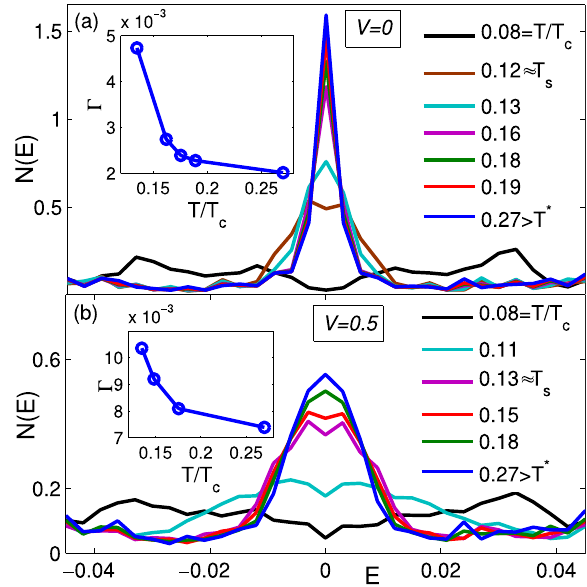
Fig. 6 Low-energy density of states. Spatially averaged density of states N ( E ) within GIMT at different temperatures for clean ( a ) and disordered samples ( b ). N ( E ) is extracted with a constant broadening parameter, which excludes the temperature broadening caused by the Fermi – Dirac distribution. A clear zero-bias peak is seen for T > T s , with insets showing its full width at half maximum, FWHM. The increase of FWHM with decreasing temperature shows that the zero- bias peak is broadened beyond the Fermi – Dirac distribution effects, i.e. a temperature-independent effect. For T < T s , N ( E ) develops a full gap (small remnant N ( E ) inside the gap is due to the broadening of the delta-function). Plots for fi nite disorder are averaged over fi ve disorder con fi